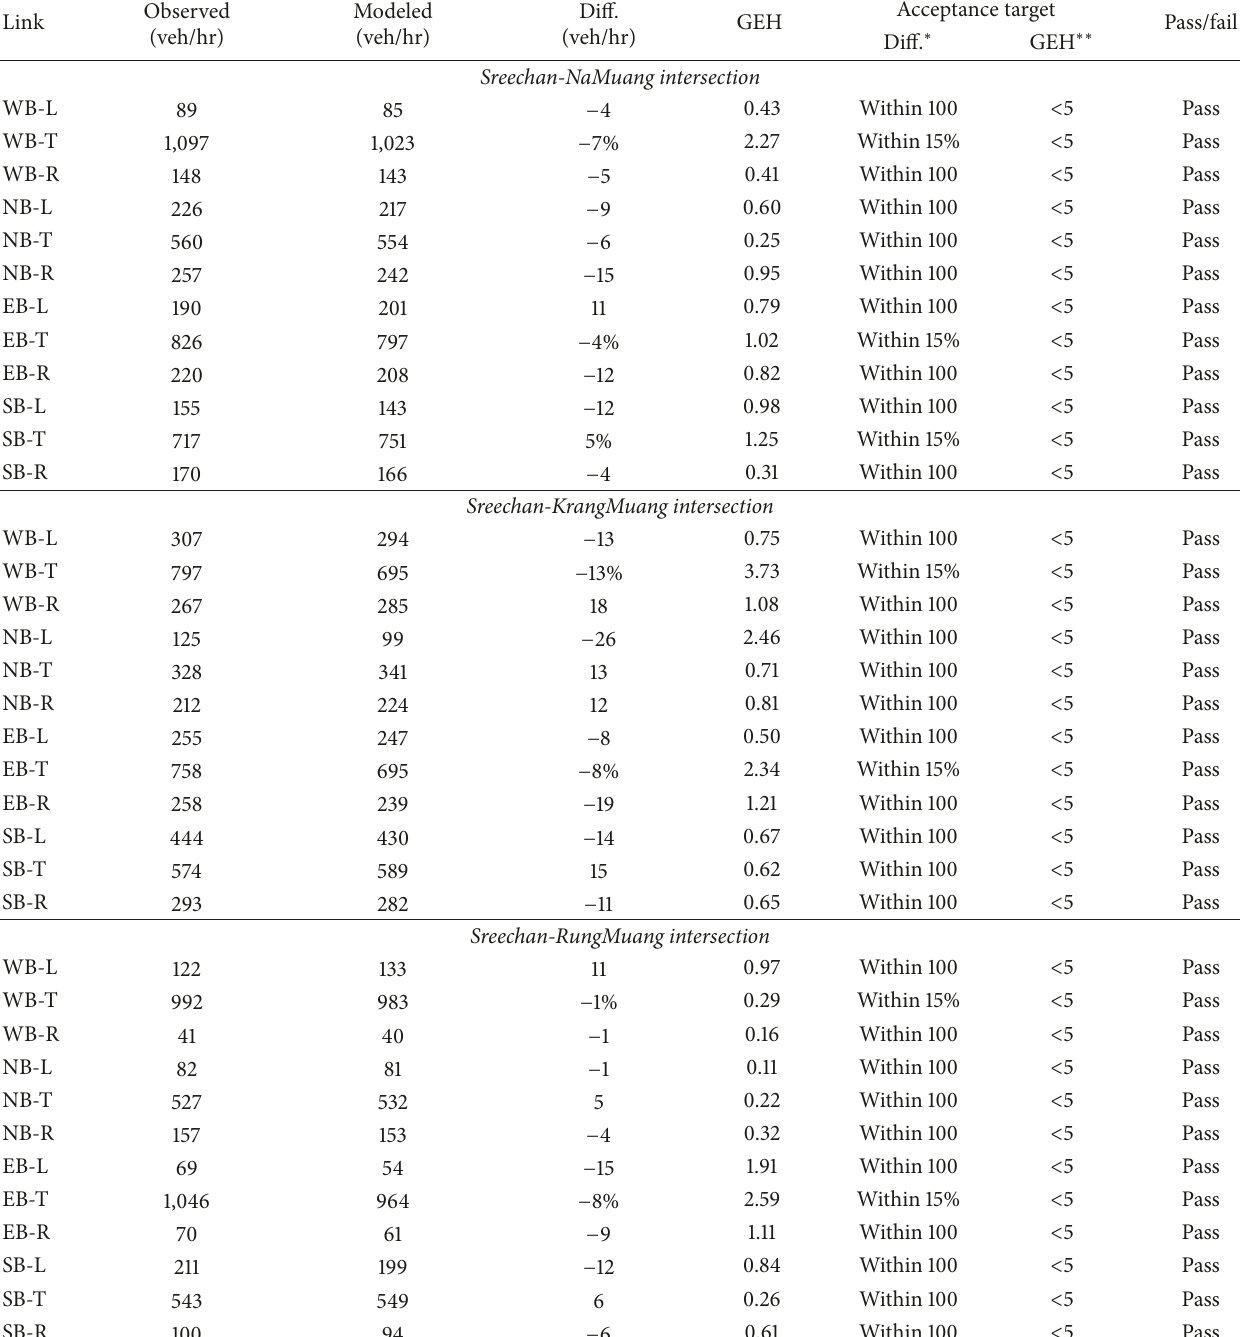
Table 2: Results of traffic flow model